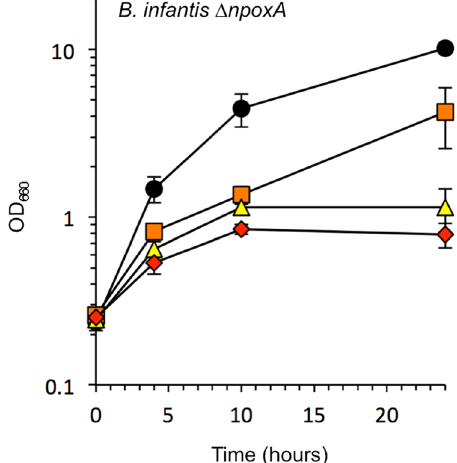
Figure 4. Growth of the ∆ npoxA mutant of B. infantis in liquid shake culture at various O 2 concentrations. Circles, 100% N 2 cultures; squares, 5% O 2 /95% N 2 cultures; triangles, 10% O 2 /90% N 2 cultures; diamonds, 20% O 2 /80% N 2 cultures. Data represent the average ± SD of four independent